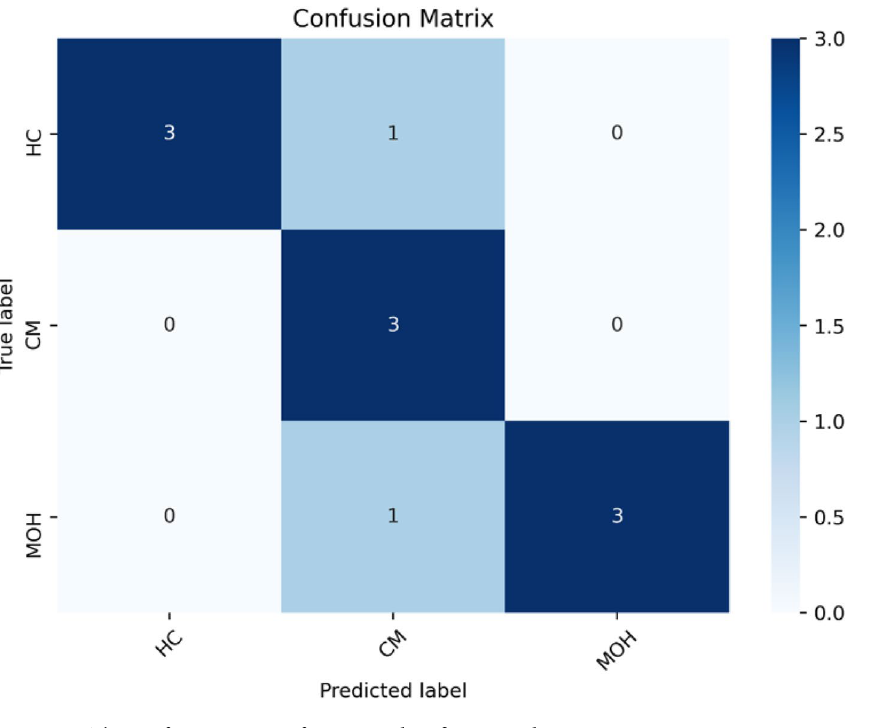
Figure 5. The confusion matrix of Stepwise classification—three groups.